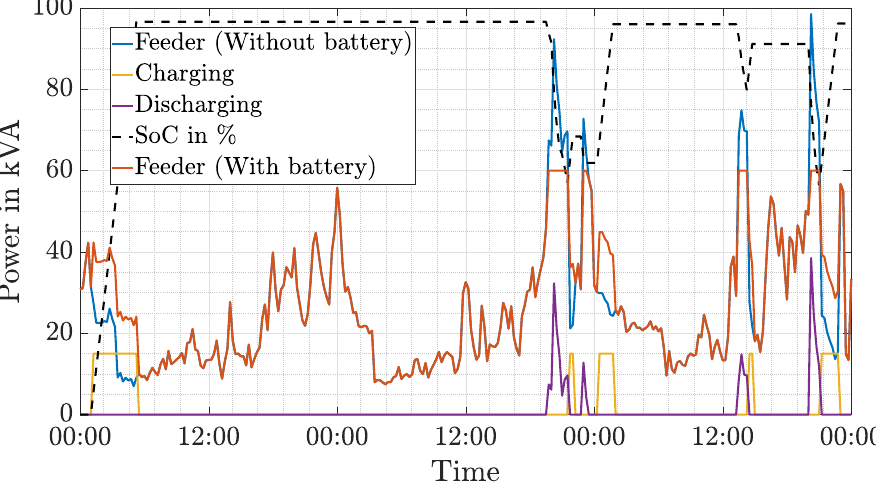
Figure 9. Exemplary course for the strategy including measurements at the storage. Table 5. Estimation faults for the minimum voltage for different